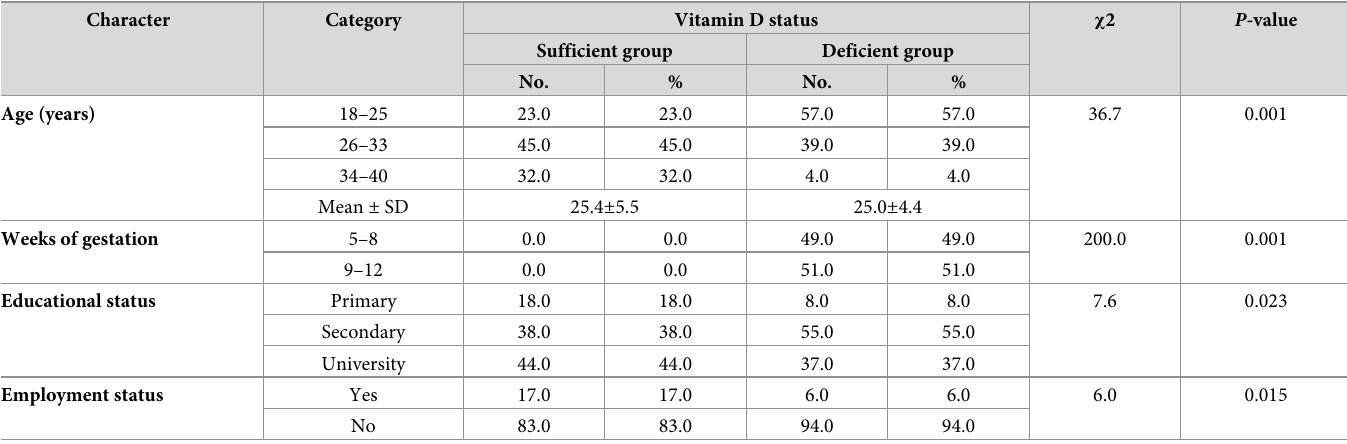
Table 1. Basic characteristics of participants in case and control groups.